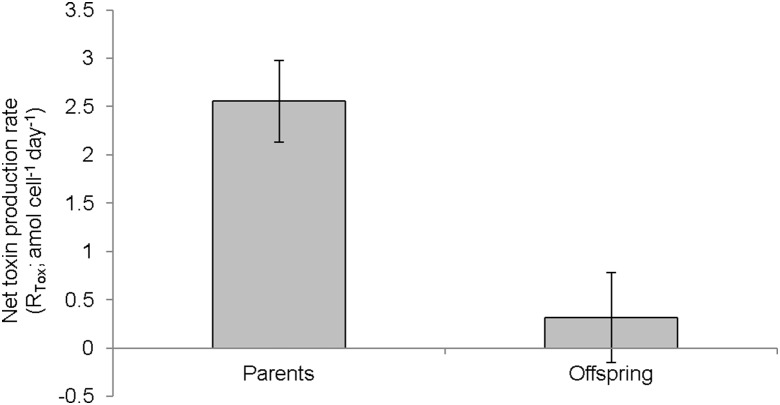
Comparison of the net toxin production rate (Rtox) of parents (2 strains) and offspring (25 strains).Error bars = ± SE, n = 10 in parents and 25 in offspring.